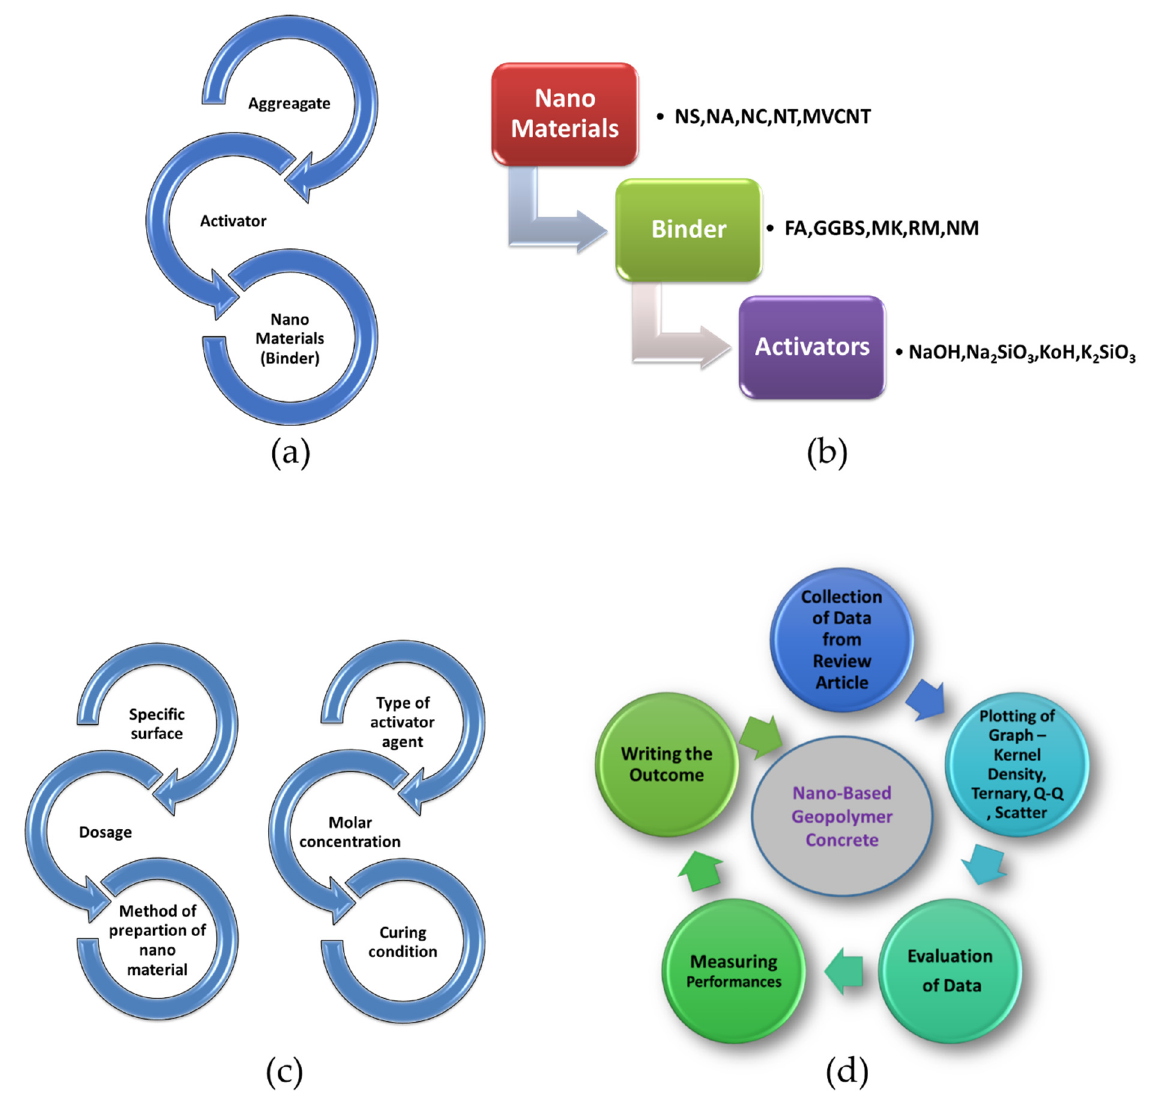
Figure 2. Schematic representations of; ( a , b ) The different ingredients of GPC and